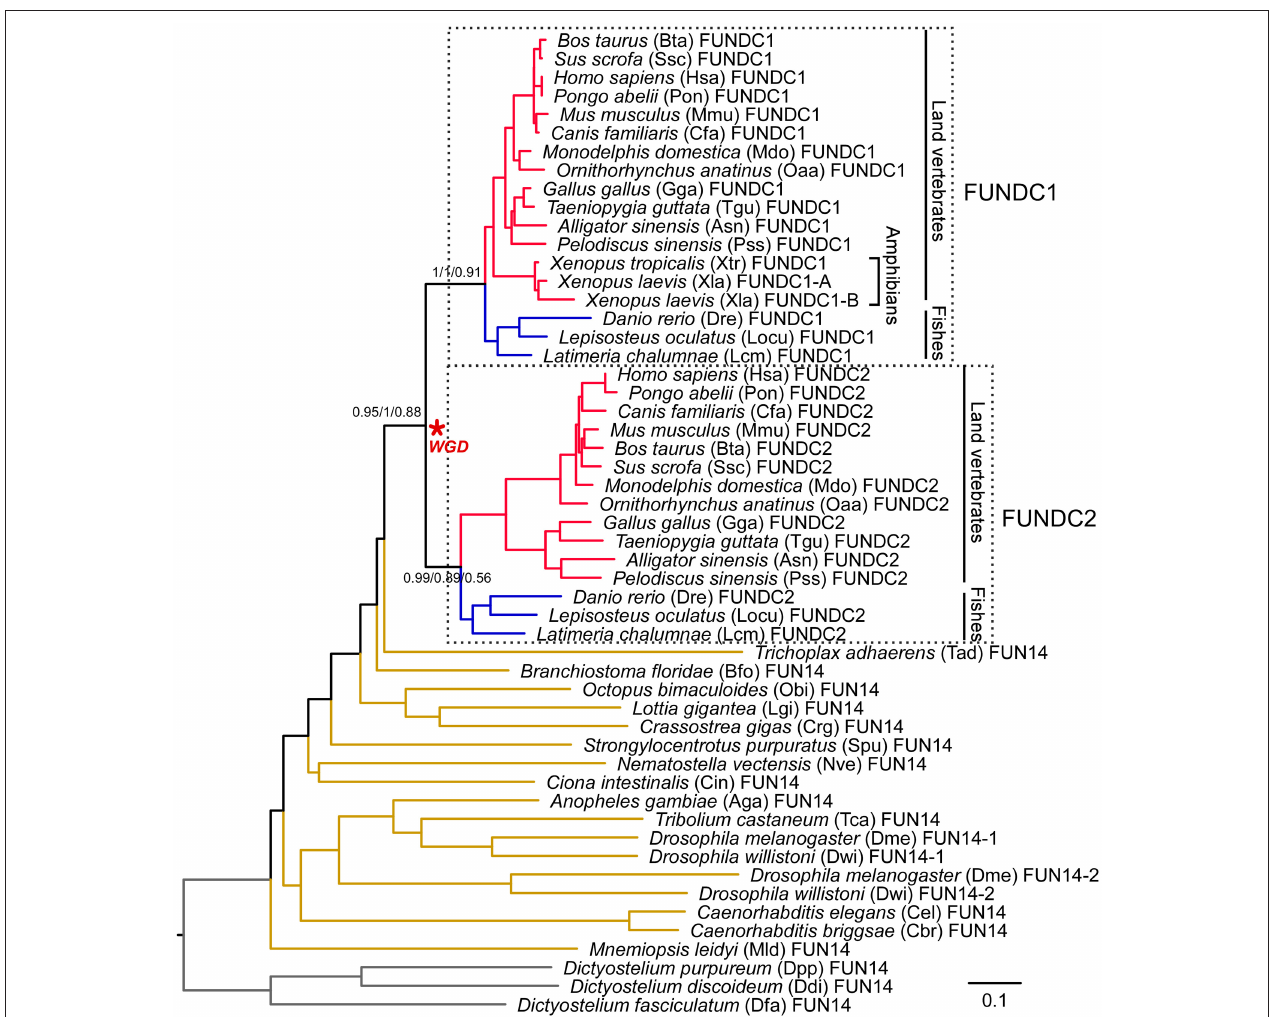
FIGURE 3 | Phylogeny of FUN14 domain-containing proteins in animals. Thirty-three animal species, representing a wide variety of metazoan lineages, were sampled. Three protozoan orthologs from Dictyostelium discoideum (Ddi), Dictyostelium fasciculatum (Dfa), and Dictyostelium purpureum (Dpp) were selected as the outgroup to root the gene tree. A total of 53 FUN14 proteins were obtained in these species and were then aligned using MAFFT with the L-INS-i method. The tree topology is from a neighbor-joining tree. Statistical support values corresponding to bootstrap neighbor-joining, Bayesian posterior probability, and maximum-likelihood aLRT values are shown next to the corresponding nodes at relevant clades. Branch lengths are proportional to the evolutionary distances between nodes and are scaled with the number of amino acid substitutions per site. Each leaf node is depicted as a full species name, followed by a three- or four-letter abbreviation of the species name (some listed in Table 1 ) and a gene ID. The node defining the whole-genome duplication (WGD) leading to the subfamily of FUNDC1 and FUNDC2 in vertebrates is indicated with an asterisk. Branches in red, blue and brown denote land vertebrates, fishes and invertebrates, respectively. Branches in land vertebrates and fishes are also indicated with black lines. Two clades, clustering vertebrate FUNDC1, and FUNDC2 subfamilies, are enclosed within dashed boxes and are included in molecular evolutionary and functional divergence analyses. Detailed protein information is noted in Supplementary Table 1. Proteins sequences are available in Supplementary Data 1. Sequence alignments and three trees in Newick format are available in Supplementary Data